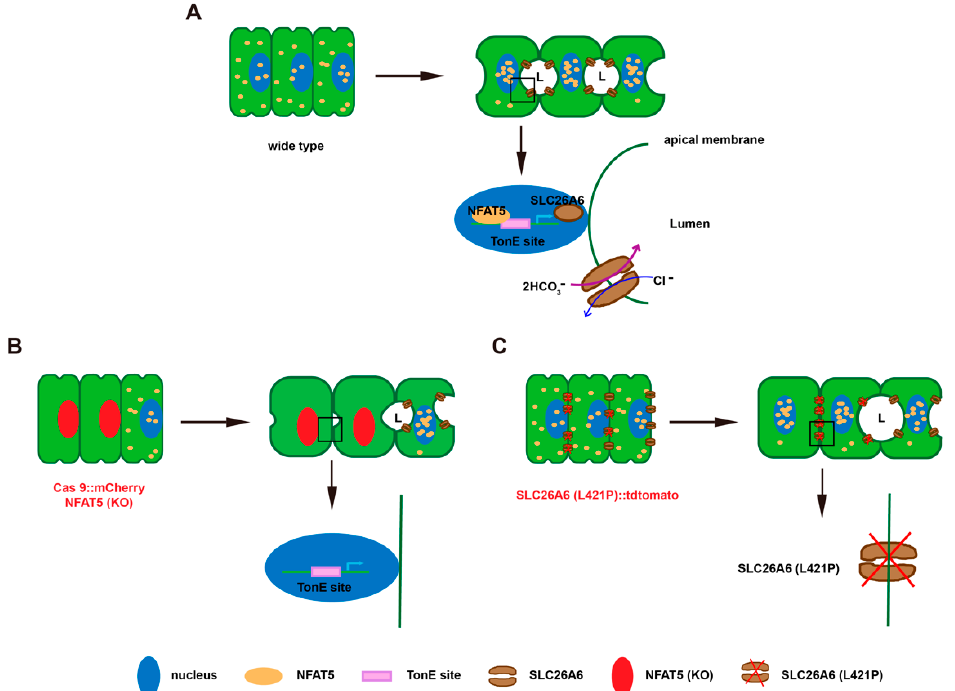
Figure 5. A working model of the regulatory roles of Ciona - NFAT5 and SLC26A6 on ascidian noto- chord lumen expansion. ( A ) The schematic diagram depicts that NFAT5 responds to hyperosmotic stress and regulates notochord lumen expansion via the SLC26A6 pathway. ( B ) Loss of NFAT5 function in notochord cells by CRISPR/Cas9 suppressed the expression of the downstream, genes including SLC26A6, and led to the defects of lumen expansion. ( C ) Loss of transport activity mutant of SLC26A6 phenocopied the similar lumen expansion defects with NFAT5 knockout.